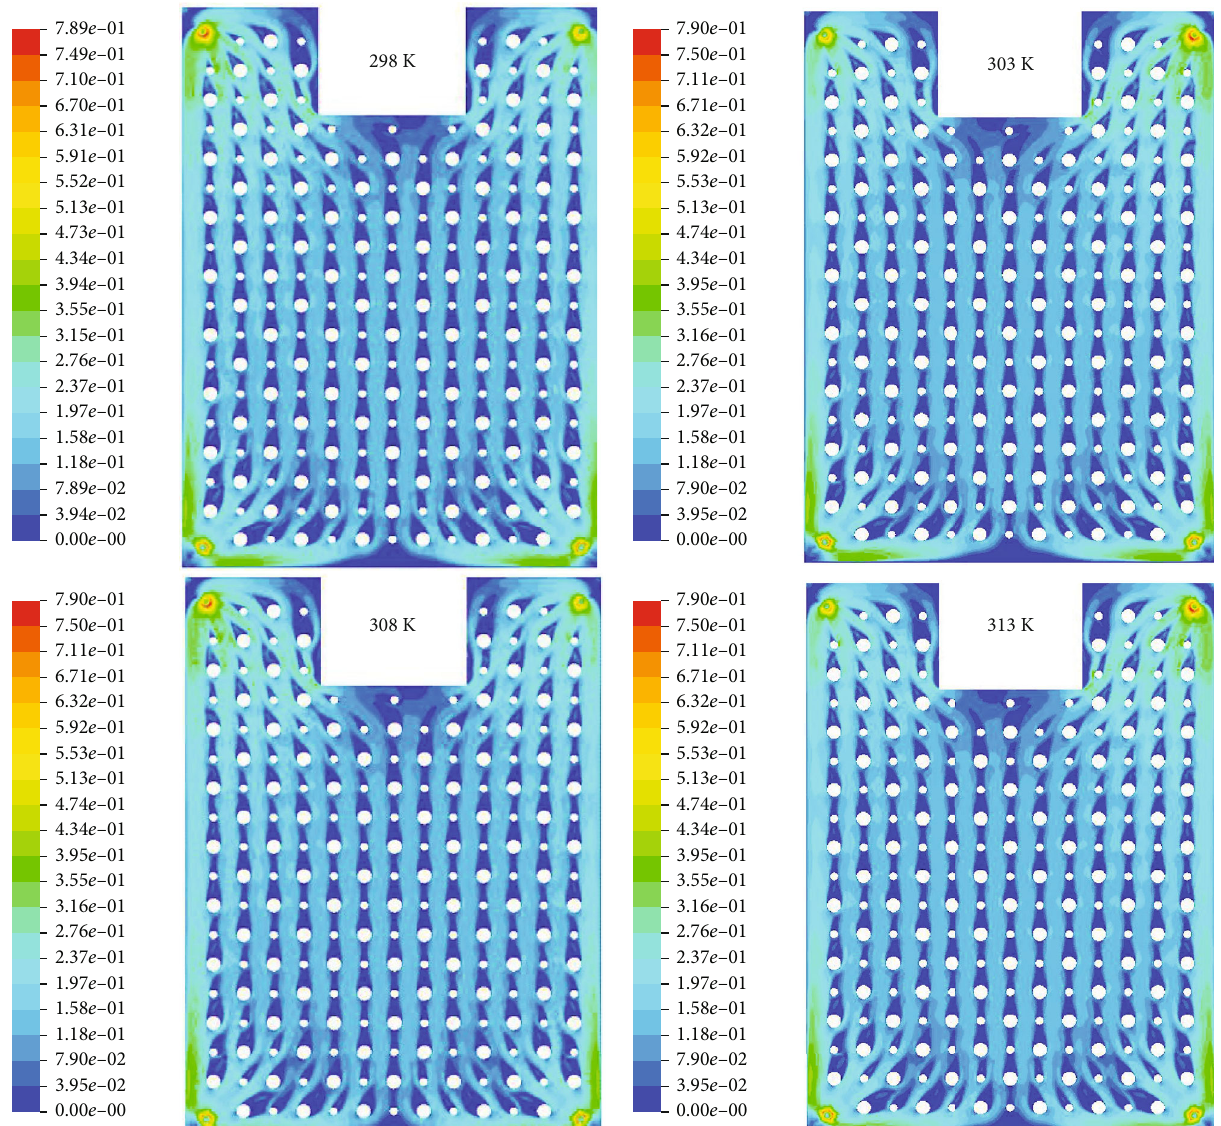
Figure 8: Velocity distribution of internal working fl uids (in m/s) at di ff erent heating surface